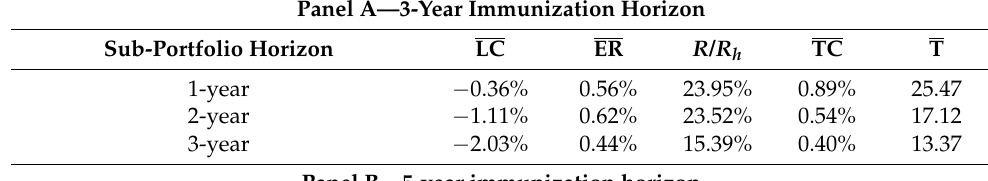
Table 3. U.S. TIPS Immunization